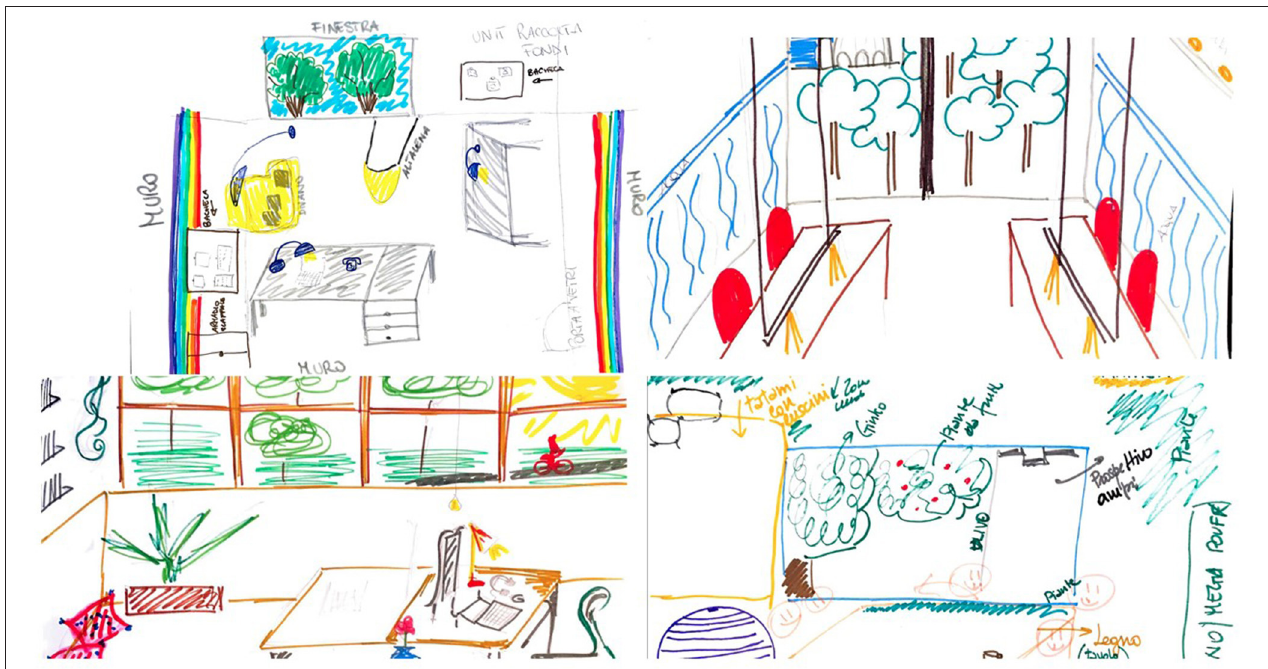
FIGURE 1 | Examples of participants’ drawings, for the session “The office I would like” (Step 1 - Session